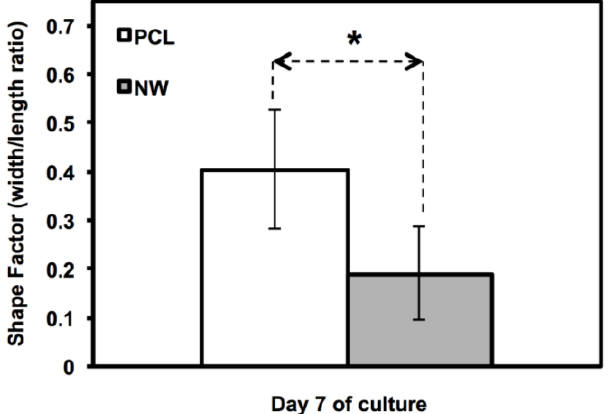
Figure 4. Shape factor approximations of Adipose derived stem cells (ADSCs) after 7 days of culture on PCL and NW. Asterisks (*) above the pairs of data indicate statistical significance using p-value less than α =